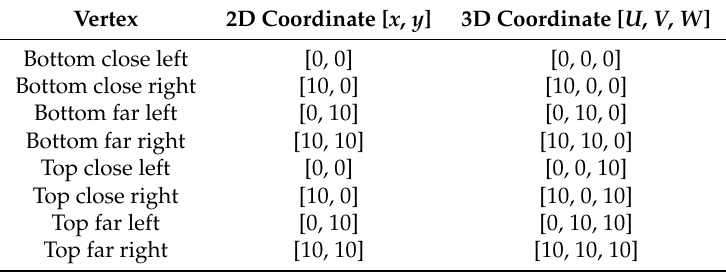
Table 5. Respective cube vertex coordinates in 2D and